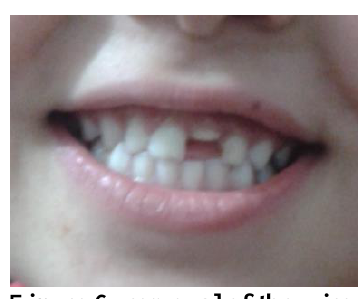
Figure 6: removal of the wire.